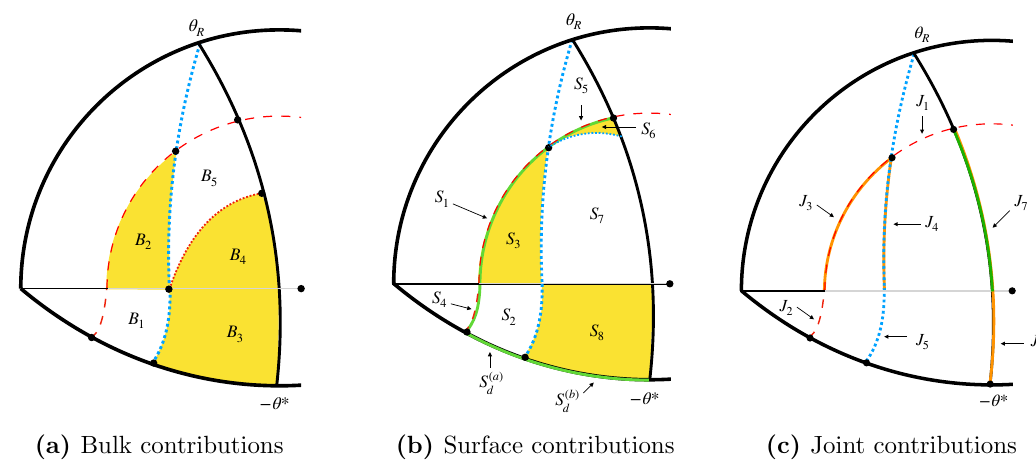
Figure 11. Illustrations of the various contributions in the evaluation of the subregion CA proposal for an interval which is symmetric around the defect. The illustrations focus on the right patch, but of course, equivalent contributions exist for the left patch. The red dashed line represents the cuto(cid:11) and the middle dotted blue curve represents the projection of the joint formed at the intersection between the boundary of the WDW patch and the entanglement wedge. We have also included certain internal divisions between B 4 and B 5 and between S 6 and S 7 outside the defect region which we use in evaluating the relevant integrals in appendix